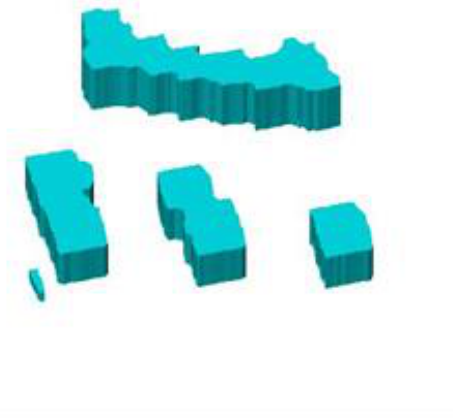
Figure 5- LoD1 3D CityGML model created by LiDAR data and building foot print extracted by LAStools